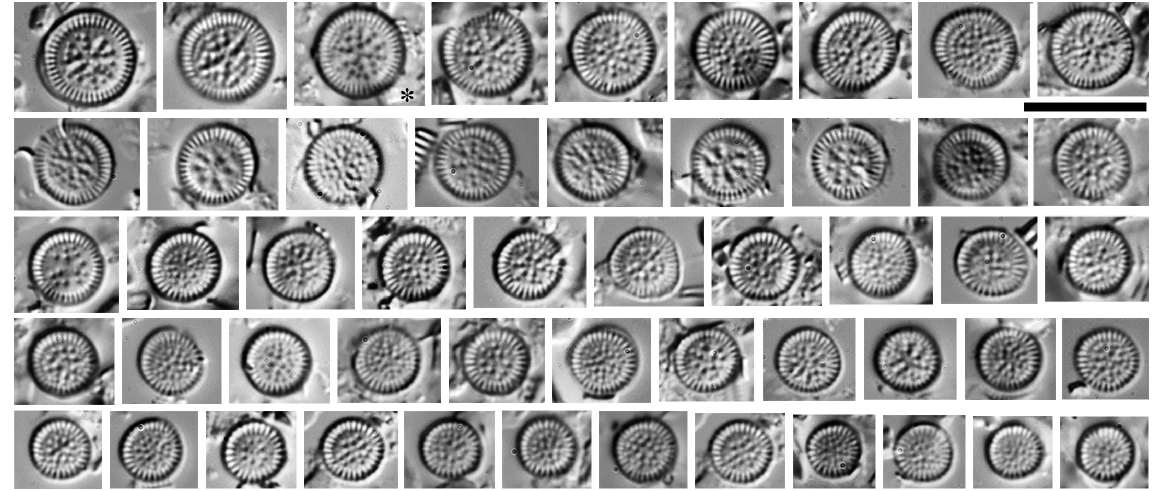
Fig. 1. Tertiarius minutulus sp. nov., LM valve views, Lake Ohrid, North Macedonia. The asterisk indicates the holotype. Scale bar = 10